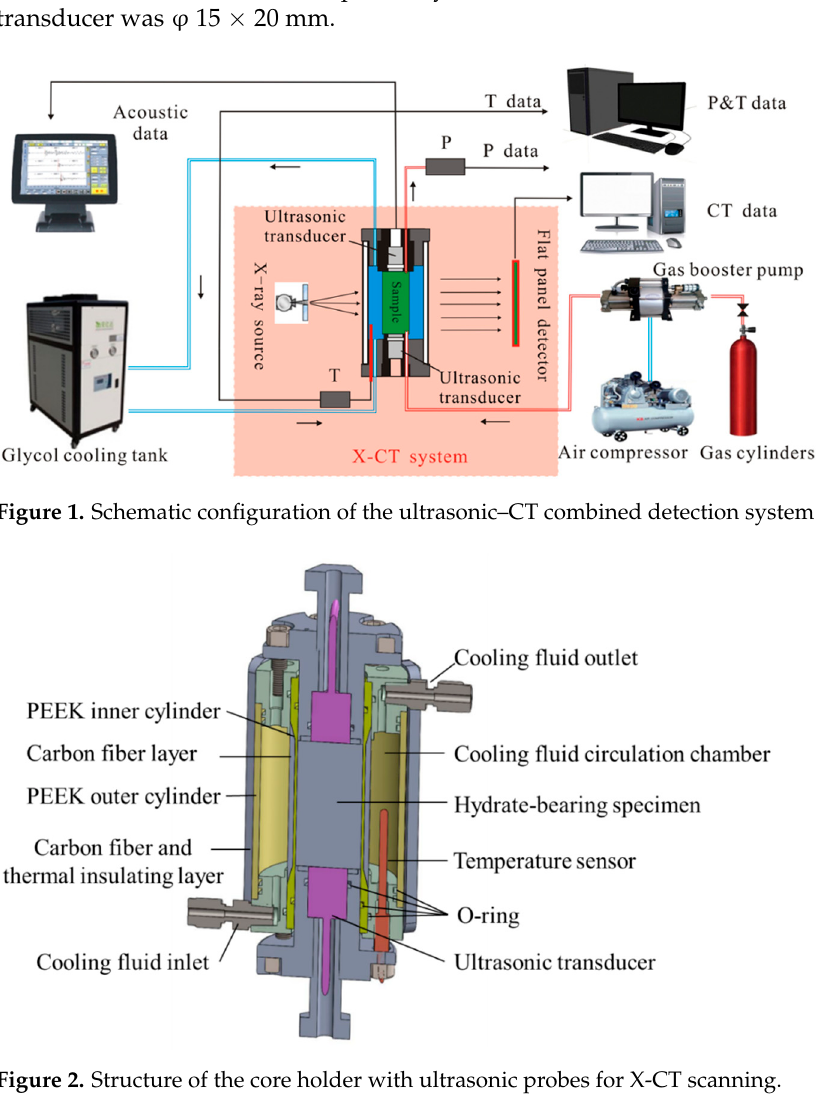
Figure 2. Structure of the core holder with ultrasonic probes for X-CT scanning.